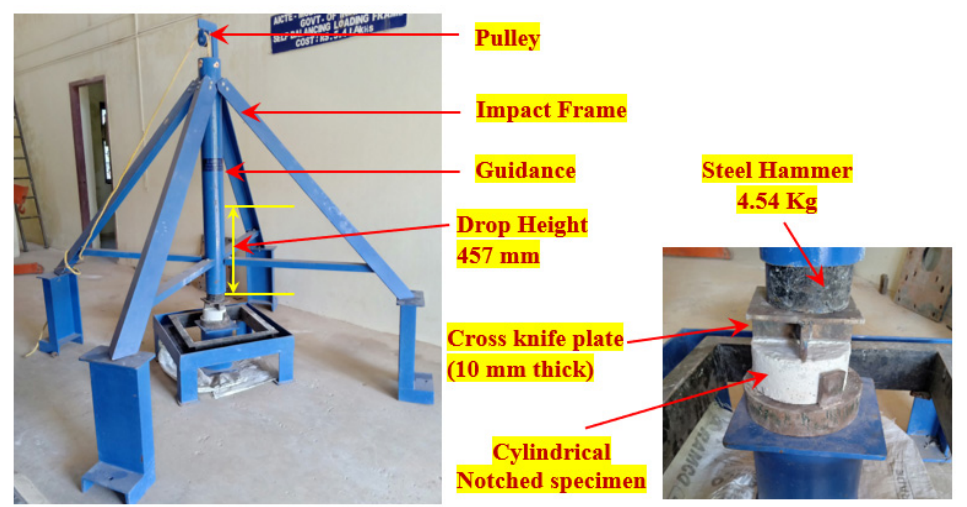
Figure 6. The Impact-test setup.